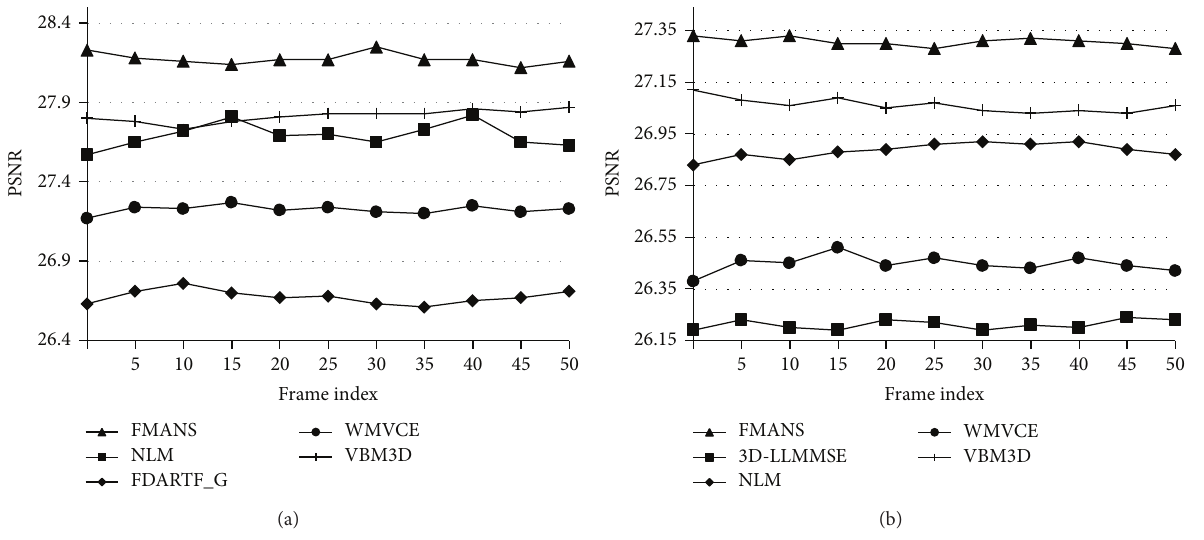
Figure 4: PSNR (dB) for the different methods applied to (a) Flowers ( 𝜎 2 = 0.005 ) and (b) Tennis ( 𝜎 2 = 0.015 ).